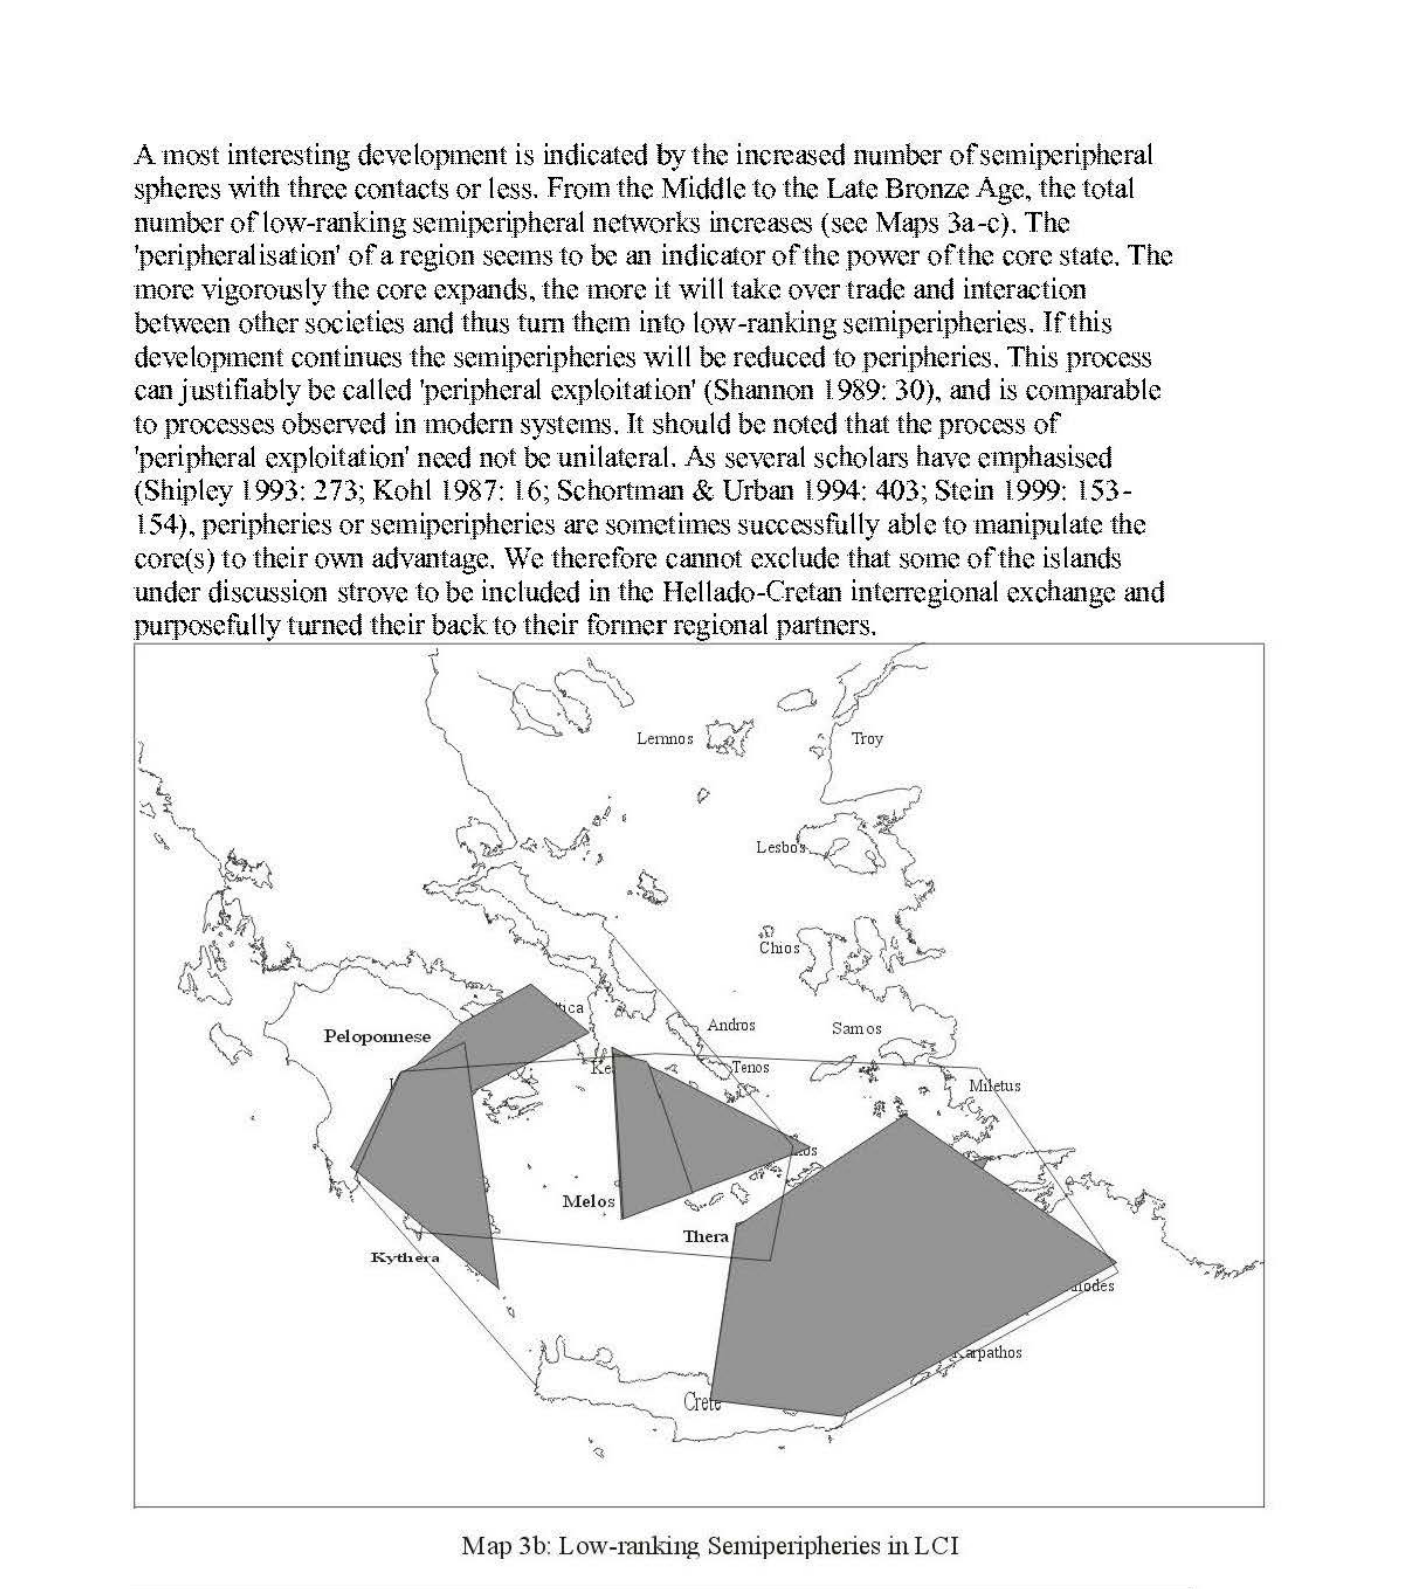
Map 3b: Low-ranking Semipeliphe1ies in